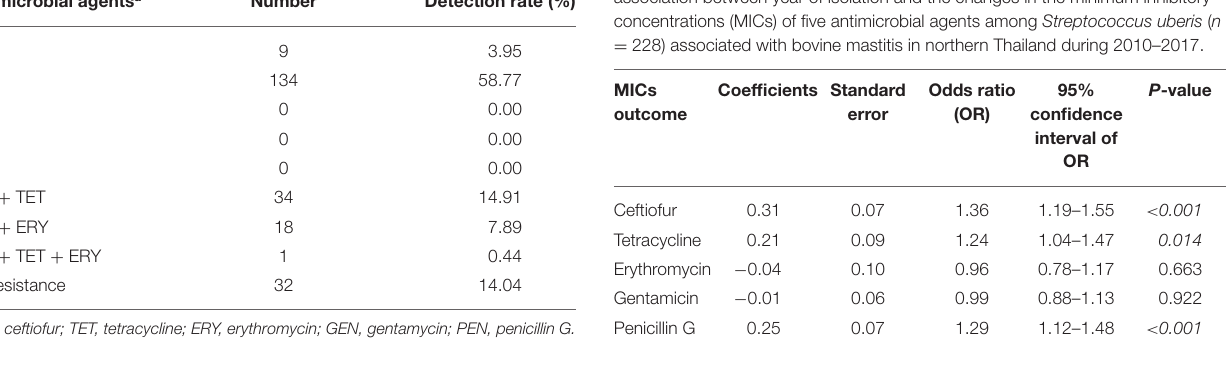
TABLE 6 | The five proportional odds cumulative logit models depicting the association between year of isolation and the changes in the minimum inhibitory